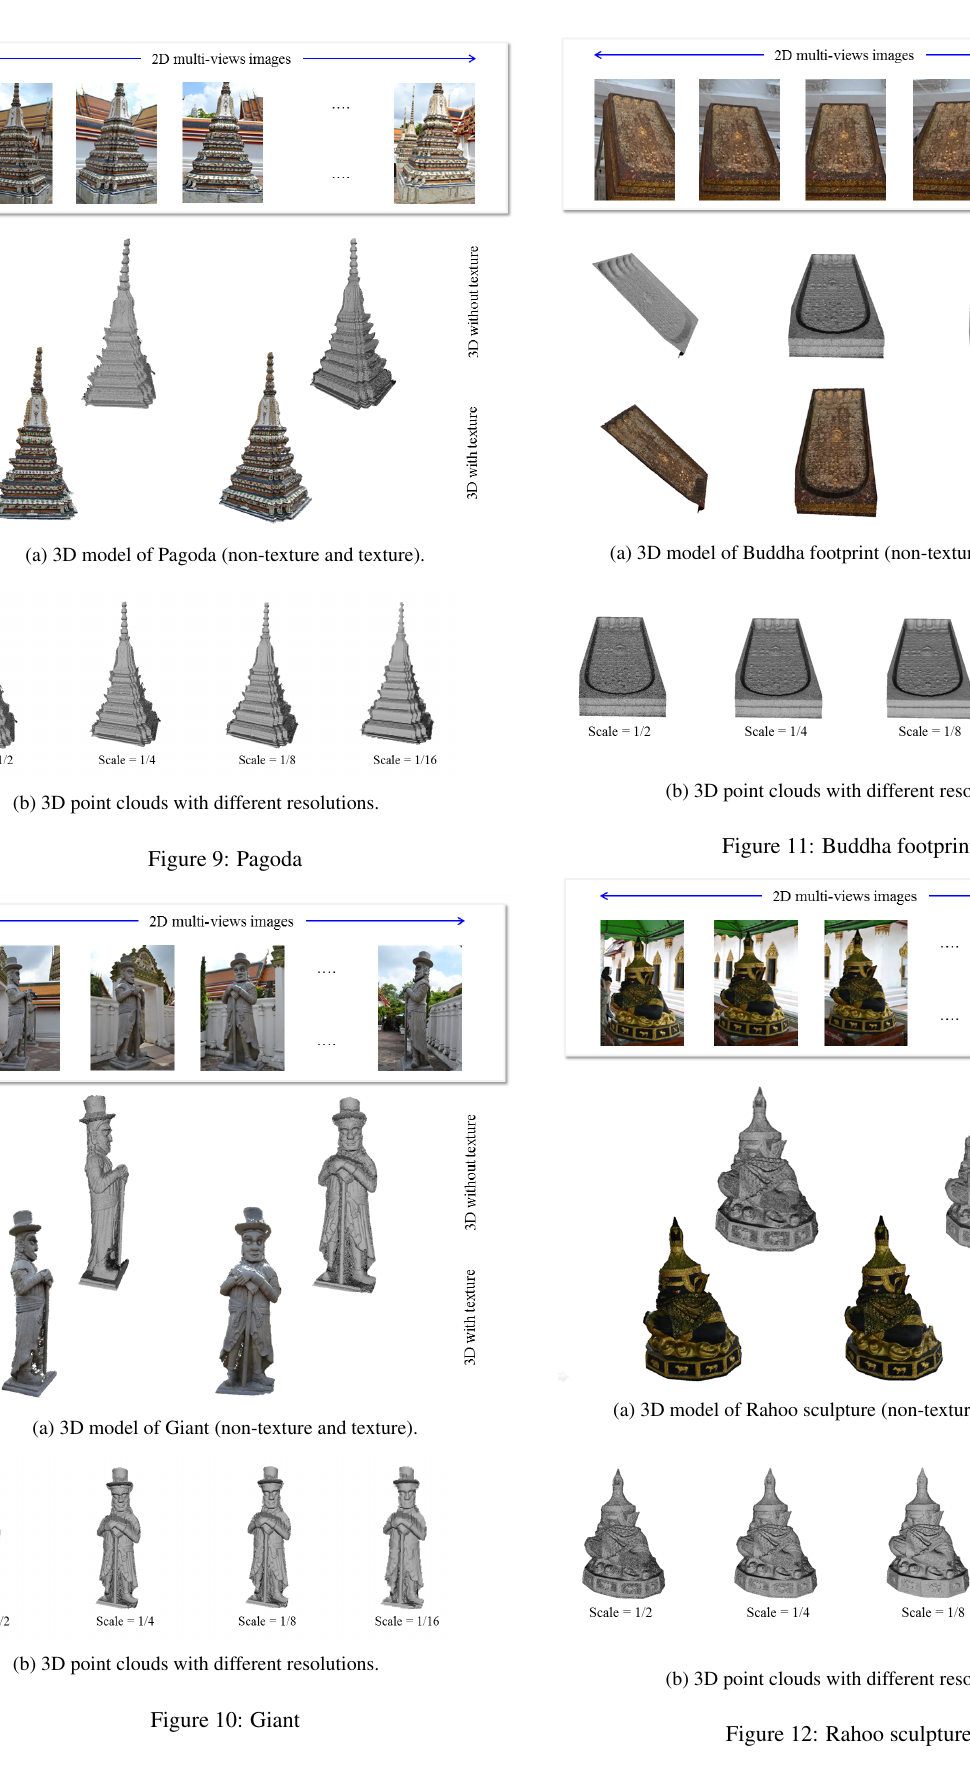
(b) 3D point clouds with different resolutions. Figure 12: Rahoo